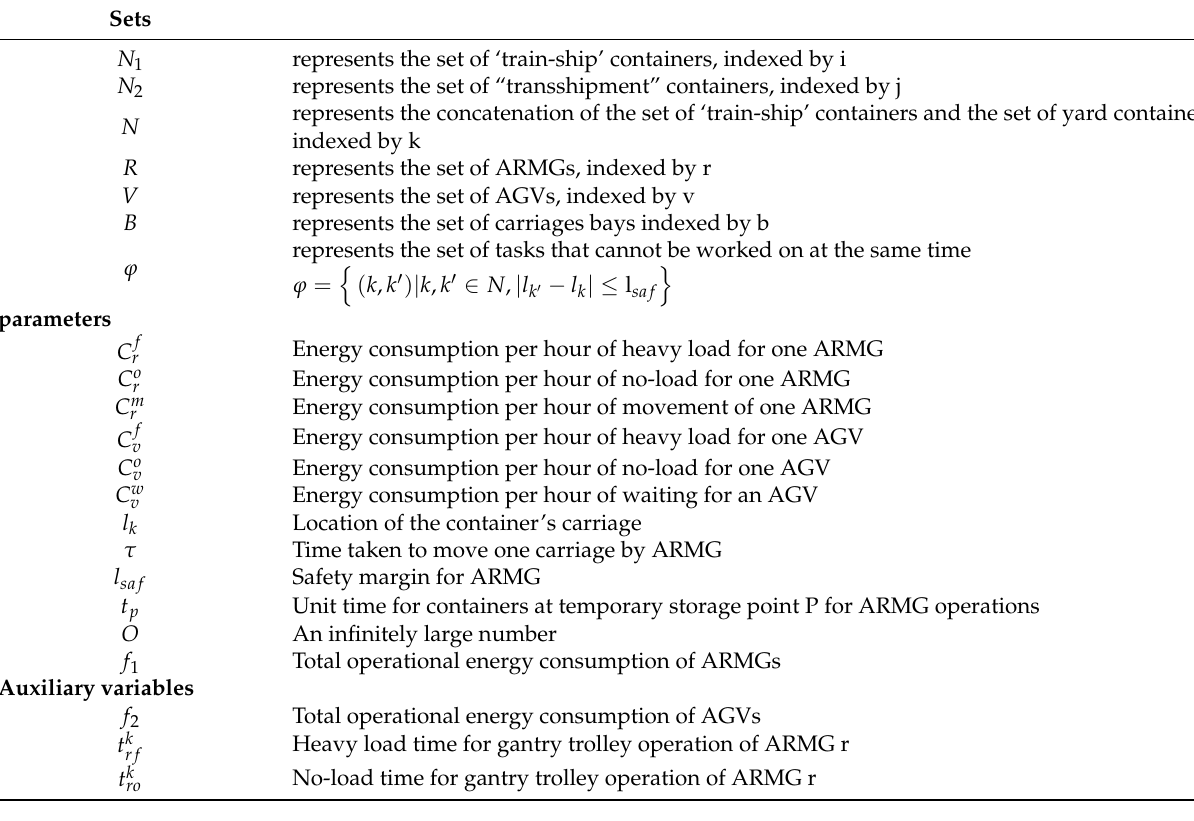
Table 2. Sets, parameters, and